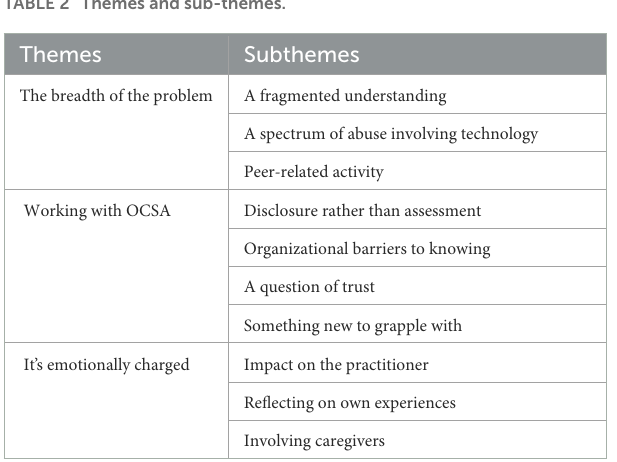
TABLE 2 Themes and